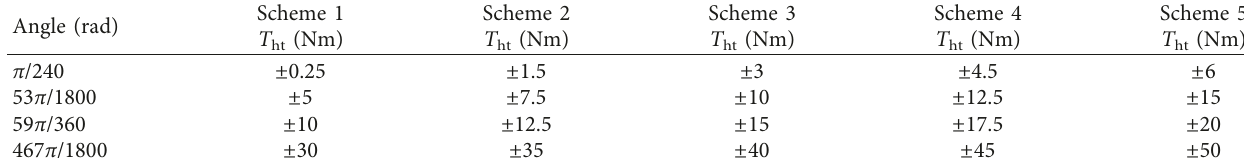
Table 4: Schemes of DMF hysteresis torque